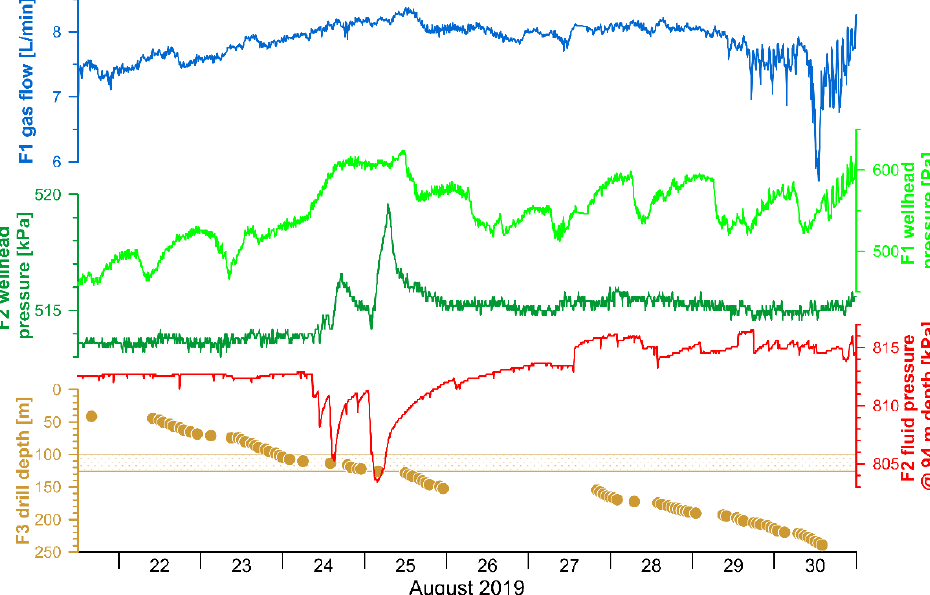
Figure 11. Response of F1 and F2 to drilling activities at F3. From the top: F1 gas flow, wellhead pressure at F1 and F2, and F2 fluid pressure at 94 m depth. The brown curve indicates the progress of the F3 drilling operation.